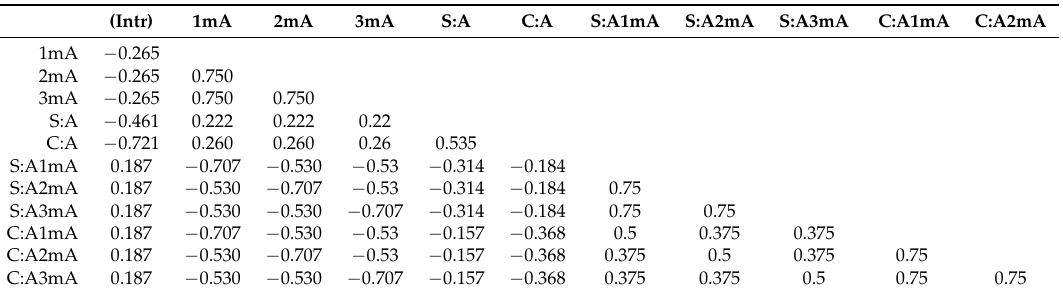
Table 4. Mixed model—Correlation of fixed effects